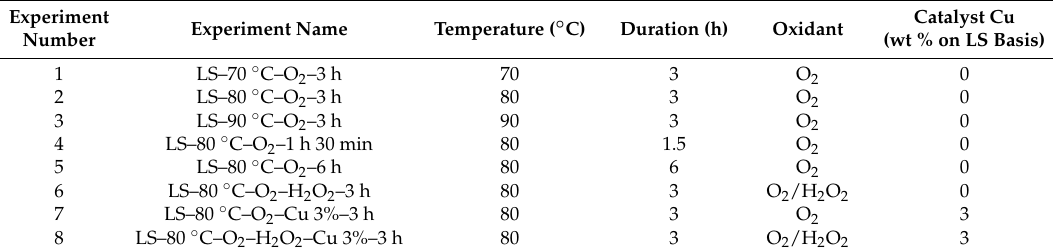
Table 2. Experimental conditions for LS